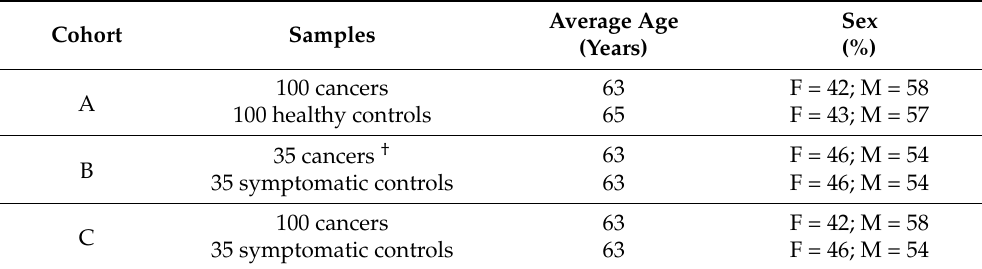
Table 1. Samples and patient details of the cohorts analyzed. (F, females; M, males).